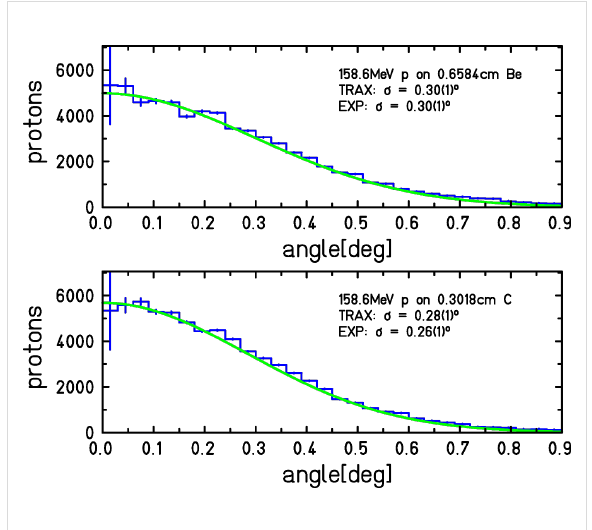
Figure 7: Simulated angular distributions of 158.6 MeV protons inci- dent on 0.66 cm beryllium (upper picture) and 0.30 cm carbon (lower picture) with TRAX. The binning of the histogram in the TRAX simula- tion is 0.03 degrees. In the case of the beryllium target, fitting a Gaussian distribution to the simulated data resulted in a Gaussian width of (0.30 ± 0.01)° which is exactly the same result as experimen- tally determined in [17]. Highland's formula [18] led to a width of 0.27°. In the case of carbon, the fit to the TRAX results resulted in a Gaussian width of (0.28 ± 0.01)°, while Gottschalk et al. [17] deter- mined this width to be (0.26 ± 0.01)°. Highland's formula [18] resulted in 0.24° for the carbon